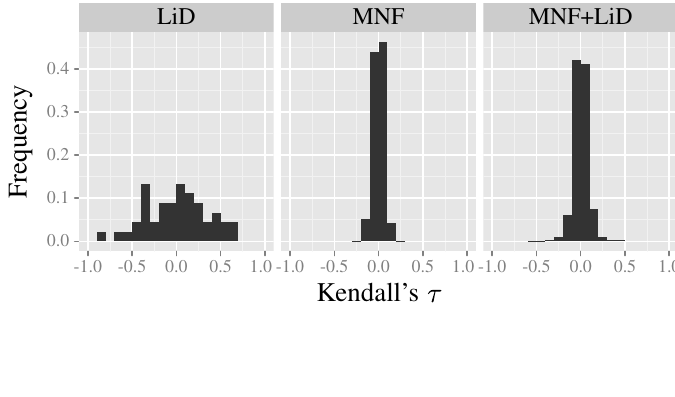
Kendall’s τ rank correlation for inter-predictor correlation. The frequency histograms are based on the upper triangular correlation matrix (diagonal removed). The LiDAR and MNF panels are based on correlation between all predictors within a predictor set, whereas the MNF+LiD panel shows only the correlation coefficients between the ten LiDAR and the MNF variables.